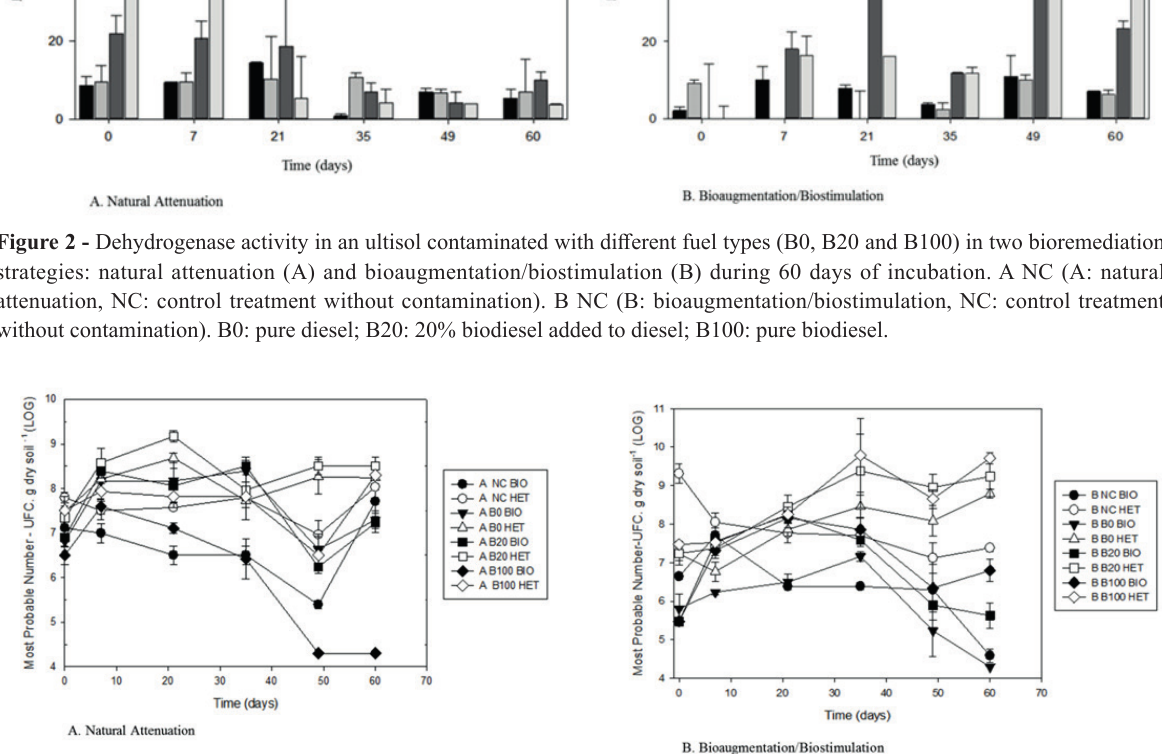
Figure 3 - Comparison of degrading (BIO) and heterotrophic (HET) microorganism counts in an ultisol contaminated by different mixtures of diesel/biodiesel (B0, B20 and B100) in two bioremediation strategies: natural attenuation (A) and bioaugmentation/ biostimulation (B) during 60 days of incubation. A NC (A: natural attenuation, NC: control treatment without contamination). B NC (B: bioaugmentation/biostimulation, NC: control treatment without contamination). B0: pure diesel; B20: 20% biodiesel added to diesel; B100: pure